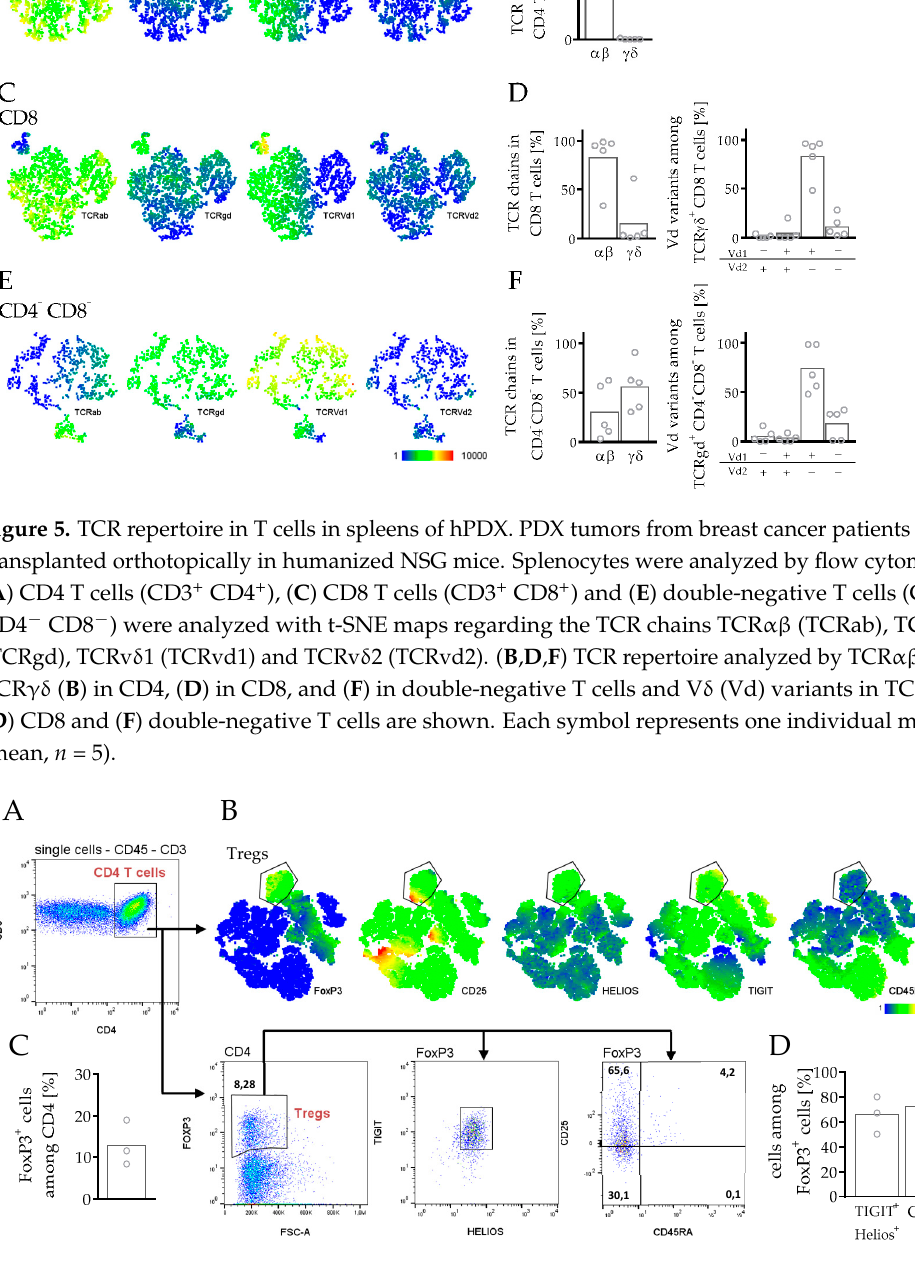
Figure 6. Phenotyping of CD4 regulatory T cells in spleens of HTMs. PDX tumors from breast cancer patients were transplanted orthotopically in humanized NSG mice. Splenocytes were analyzed by flow cytometry. ( A ) Manual gating strategy for flow cytometry analysis of human splenocytes is compared with ( B ) t-SNE maps of CD4 T cells, color-coded by the expression of different conventionally Treg markers as indicated. t-SNE map of one exemplary mouse is shown. ( C ) Quantity and ( D ) phenotyping of Tregs in spleens of all analyzed hPDX are indicated. Each symbol represents one individual mouse (mean, n = 3).